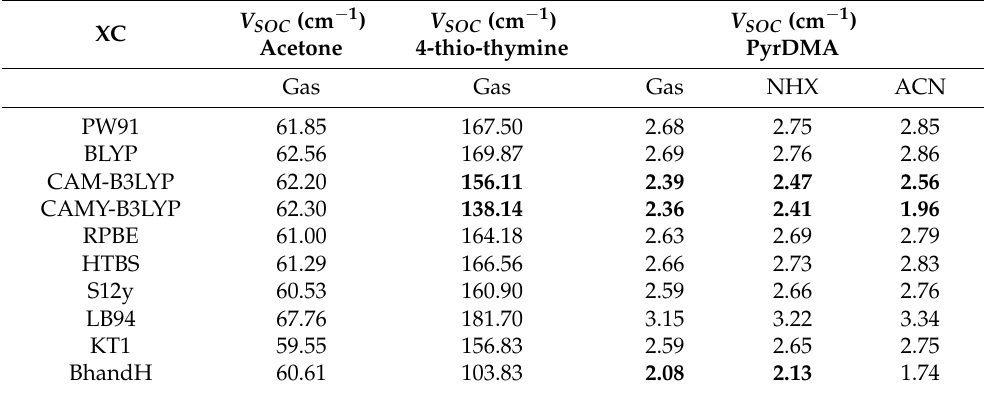
Table 2. The V SOC values for acetone, 4-thio-thymine and PyrDMA calculated with different exchange correlation functionals at the S 1 geometry